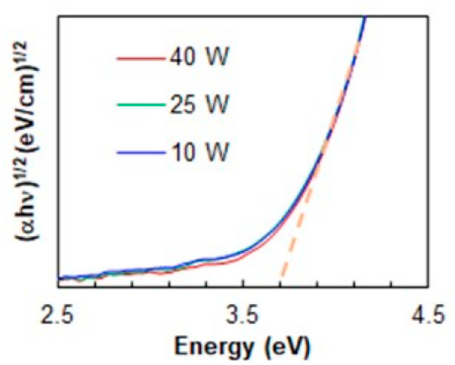
Figure 6. Tauc plot of the a-C:H coatings produced at different ion source power.